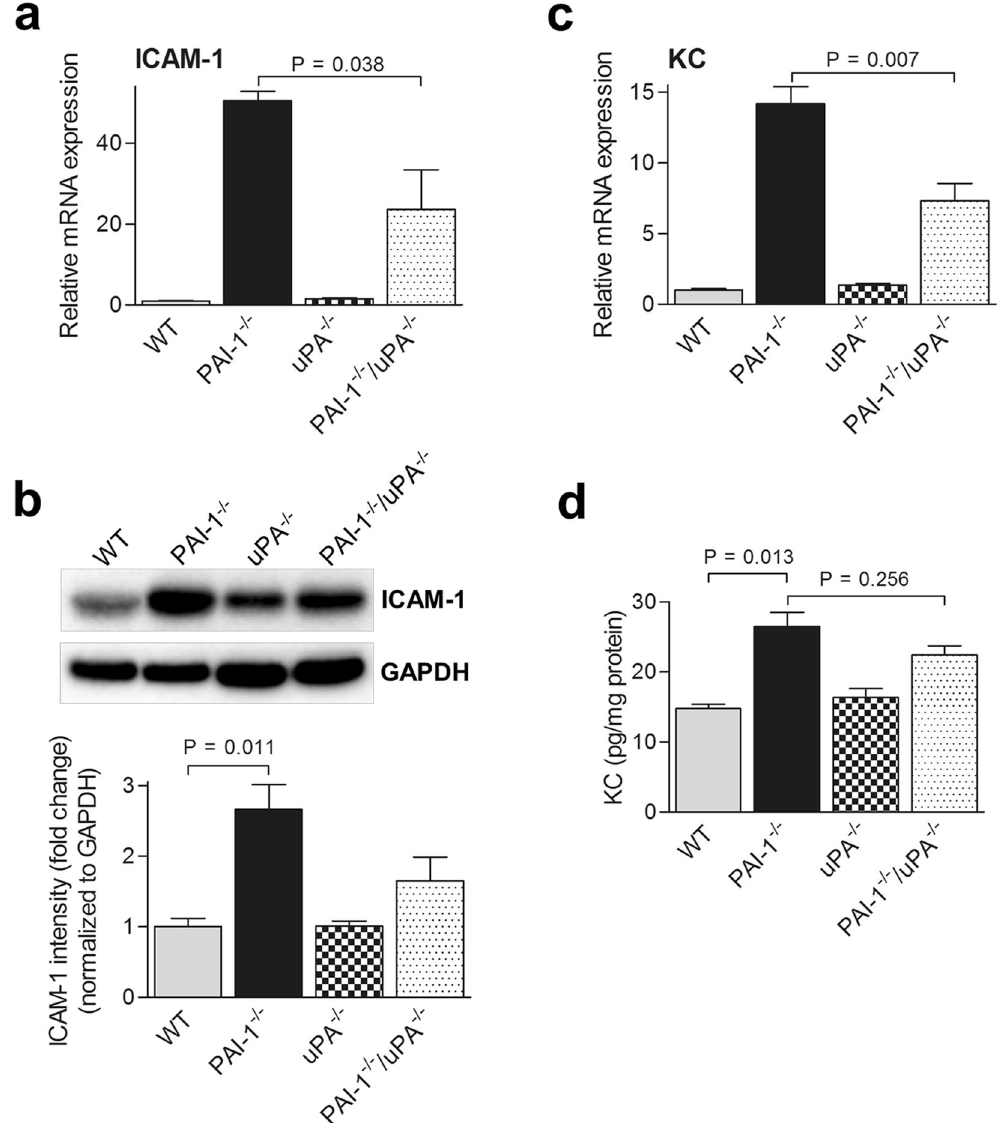
Figure 3. Inflammatory cytokine expression is attenuated in AngII-Ald-infused PAI-1 − / − /uPA − / − mice. qRT- PCR ( a ) and Western blot ( b ) analysis of ICAM-1 expression in heart tissues at 4 wk of AngII-Ald infusion. In Western blot, densitometric analysis of relative ICAM-1 expression after normalisation with GAPDH is shown in the lower panel. Western blot images are cropped for concise presentation. All uncut western blot images are provided in Supplementary Figure S6. qRT-PCR ( c ) and ELISA assays ( d ) of KC expression in heart tissues at 4 wk of AngII-Ald infusion were performed as